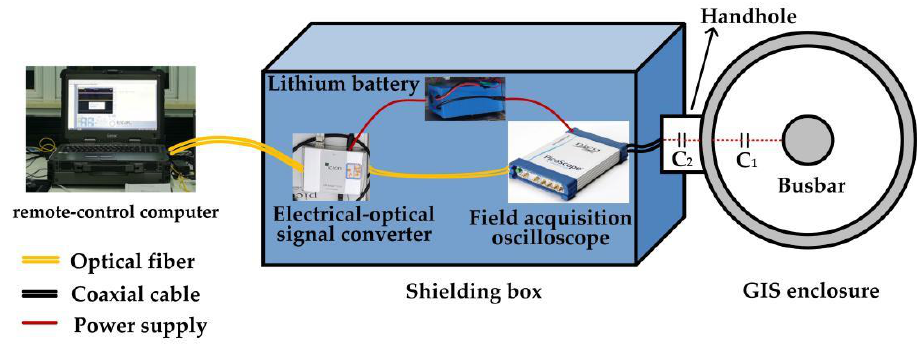
Figure 11. The overall structure of the VFTO measurement system.